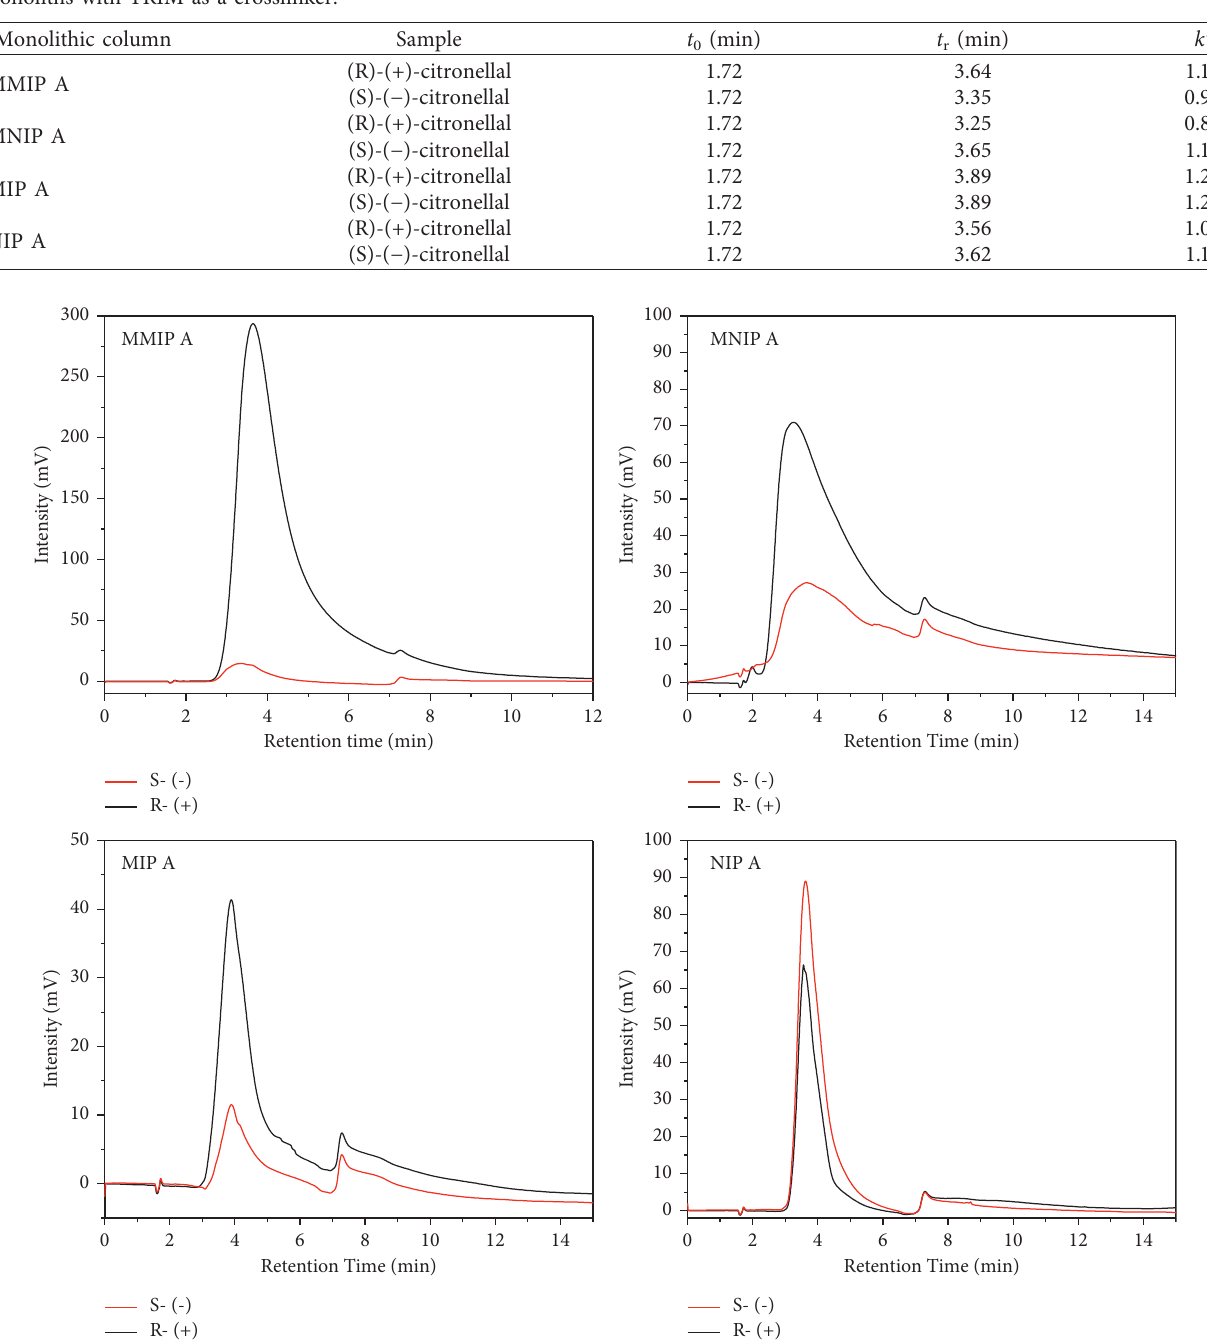
Figure 6: Comparison of MMIP, MNIP, MIP, and NIP monoliths with TRIM as a crosslinker for the elution of (R)-(+)-citronellal and (S)- ( − )-citronellal. The flow rate of 0.04mL/min and the mobile phase of 10% acetonitrile in water under the isocratic method were